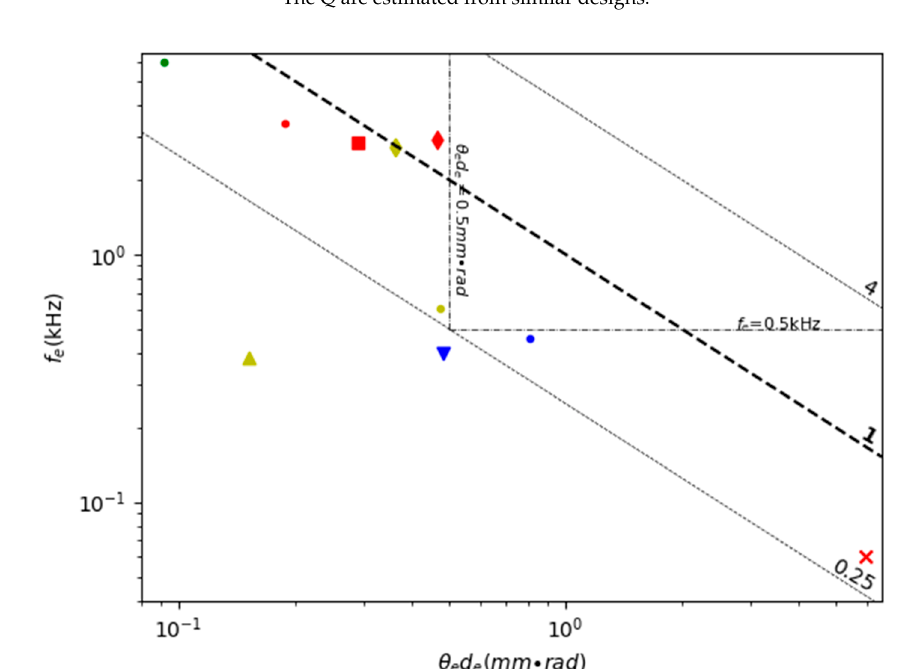
Figure 14. A comparison of 2D resonant plus non-resonant scanning MEMS mirrors.